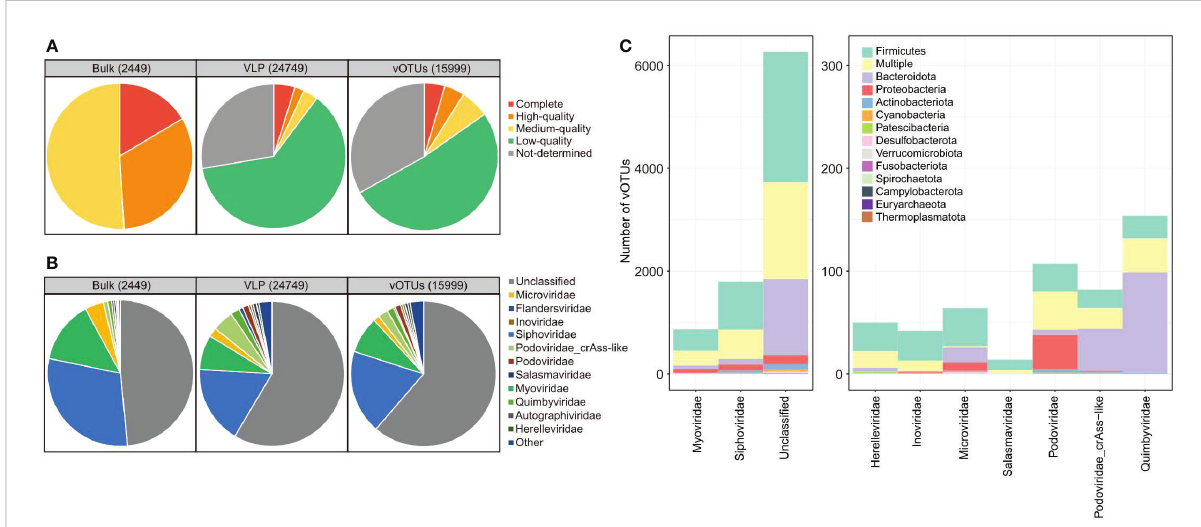
FIGURE 1 Summary of quality assessment, taxonomic assignment, and host prediction of viral sequences. (A, B) Pie plot showing the quality assessment (A) and taxonomic assignment (B) of the viral sequences identi fi ed from bulk and virome metagenomic datasets and the vOTUs. (C) The distribution of prokaryotic hosts of all vOTUs generated in this study. The vOTUs are organized by their family-level taxonomic assignment, and the host taxa are displayed by phylum. The number of vOTUs with multiple predicted hosts is indicated in